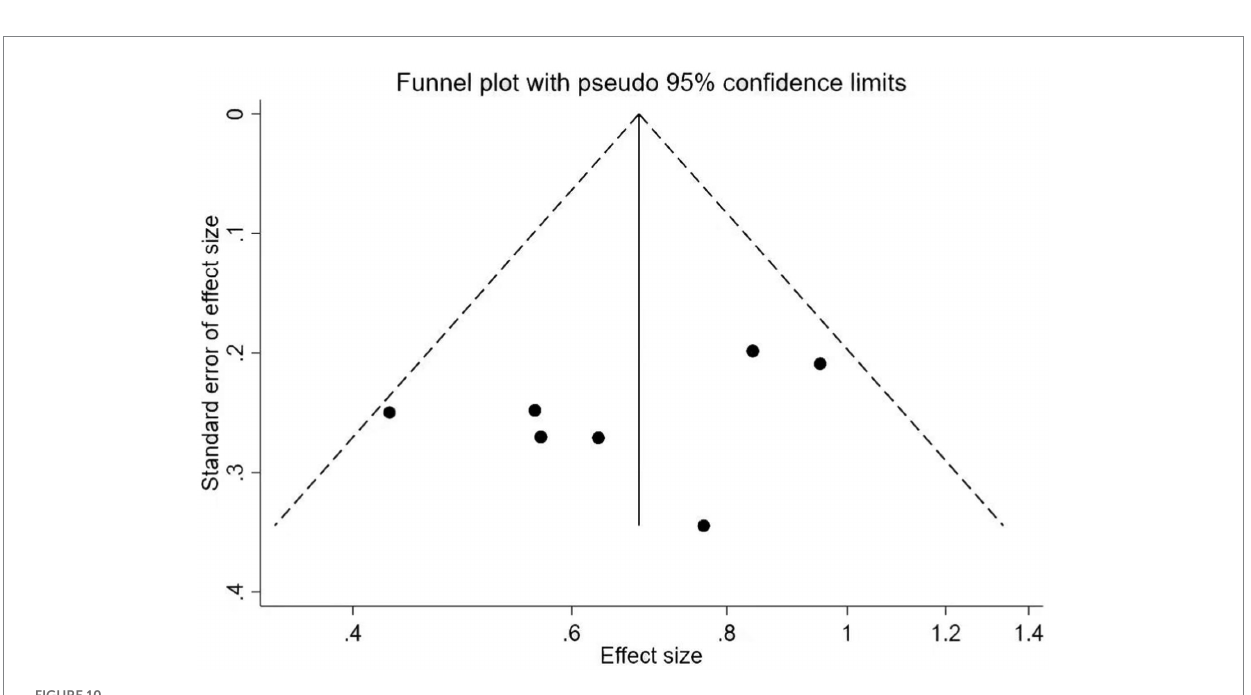
FIGURE 10 Publication bias of Trail-Making Test (TMT)